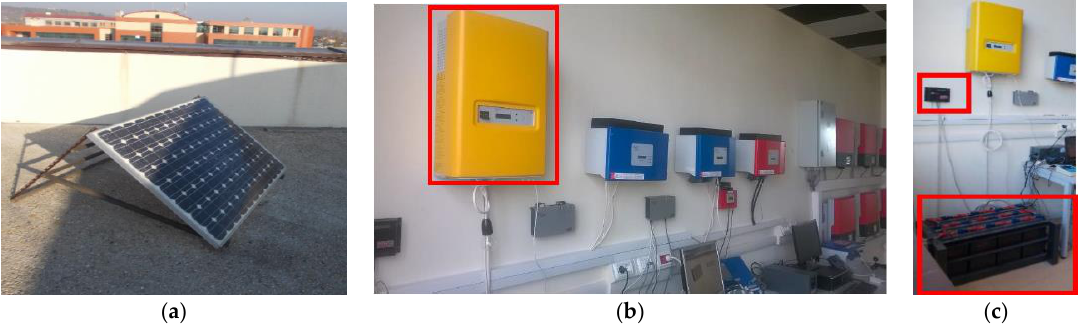
Figure 6. The components of the subsystem 2: ( a ) a photovoltaic panel; ( b ) the Sunny Island SI3324 inverter from SMA; and ( c ) the battery’s bank and the voltage regulator.